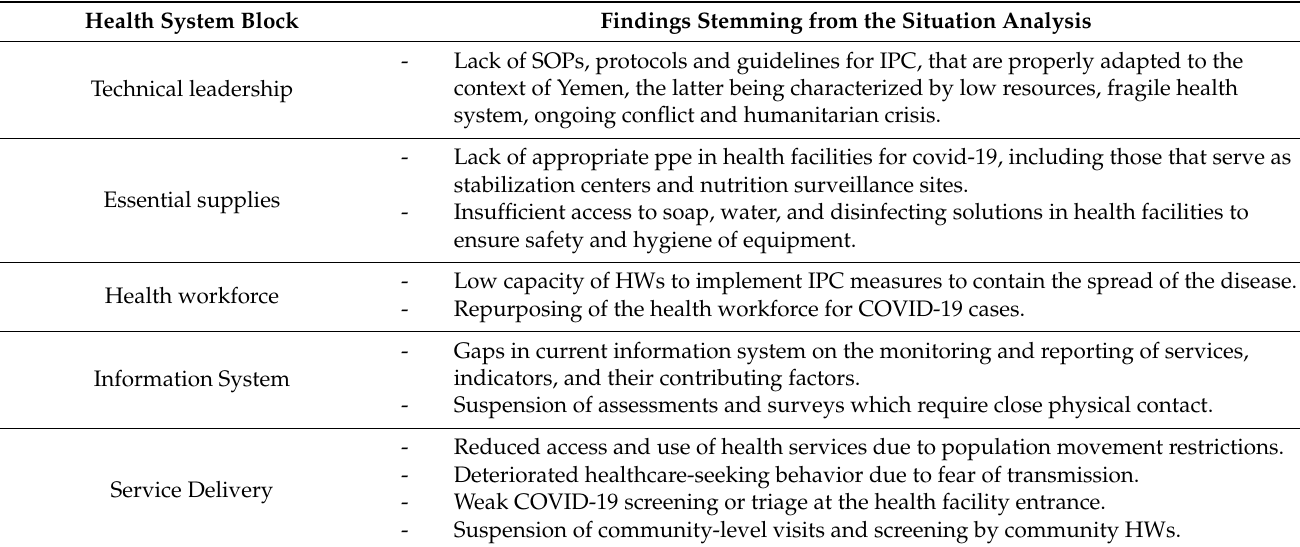
Table 2. Key findings stemming from the situation analysis by health system blocks in Yemen, to be considered in nutrition programmatic